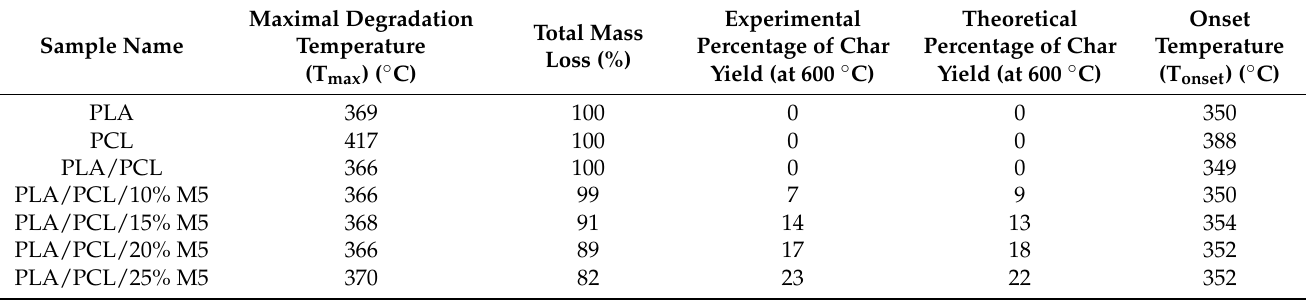
Table 3. The TGA results of PLA, PCL, their blends, and their